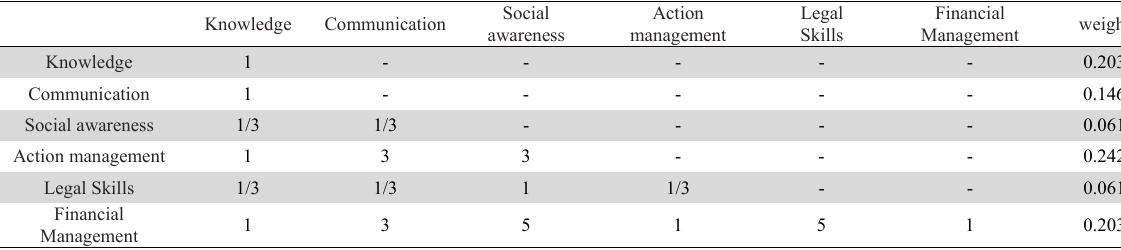
Comparisons in second level, general management